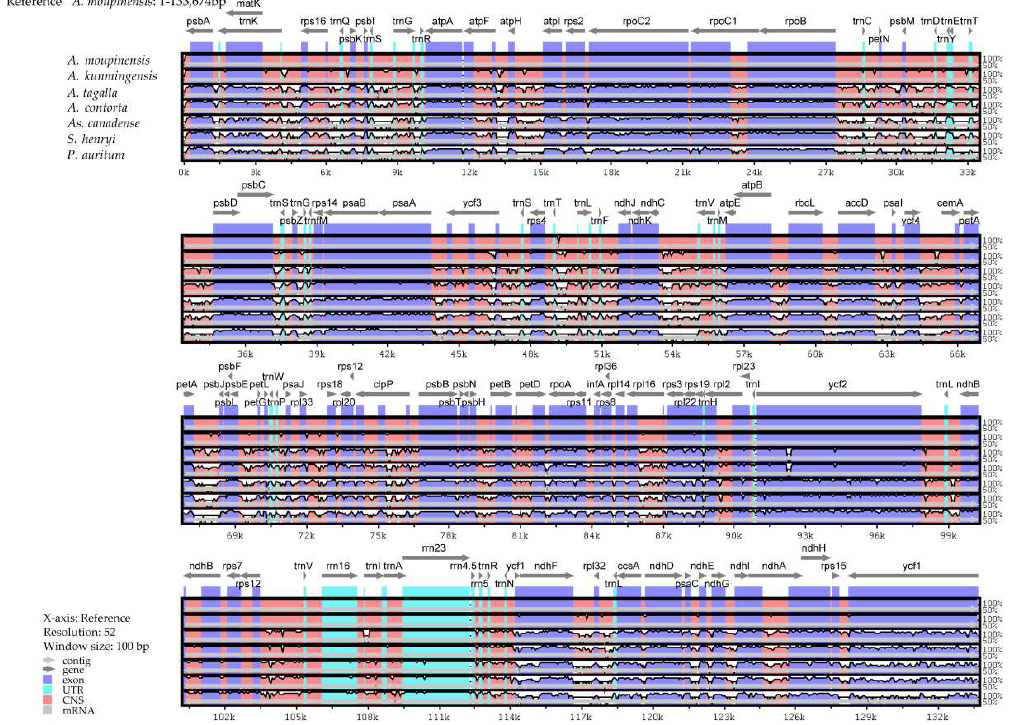
Figure 7. Sequence identity plot compared seven cp genomes with A. moupinensis as a reference by using mVISTA. Grey arrows and thick black lines above the alignment indicate genes with their orientation and the position of the IRs, respectively. A cut-off of 70% identity was used for the plots, and the Y -scale represents the percent identity from 50% to 100%.